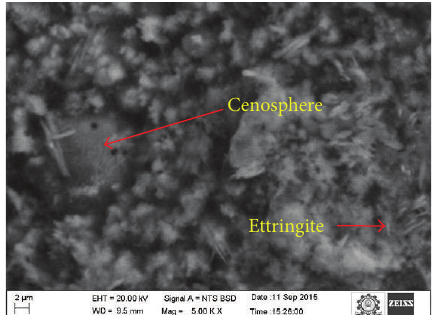
Figure 6: SEM image for SFCS20 specimen.